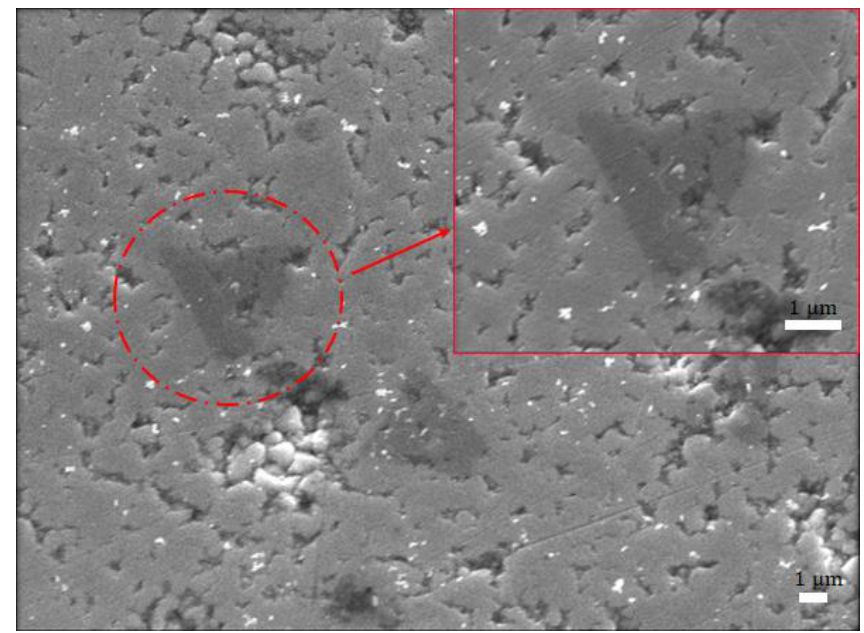
Figure 5. SEM image of MoS 2 transferred to the Cu 2 O surface.